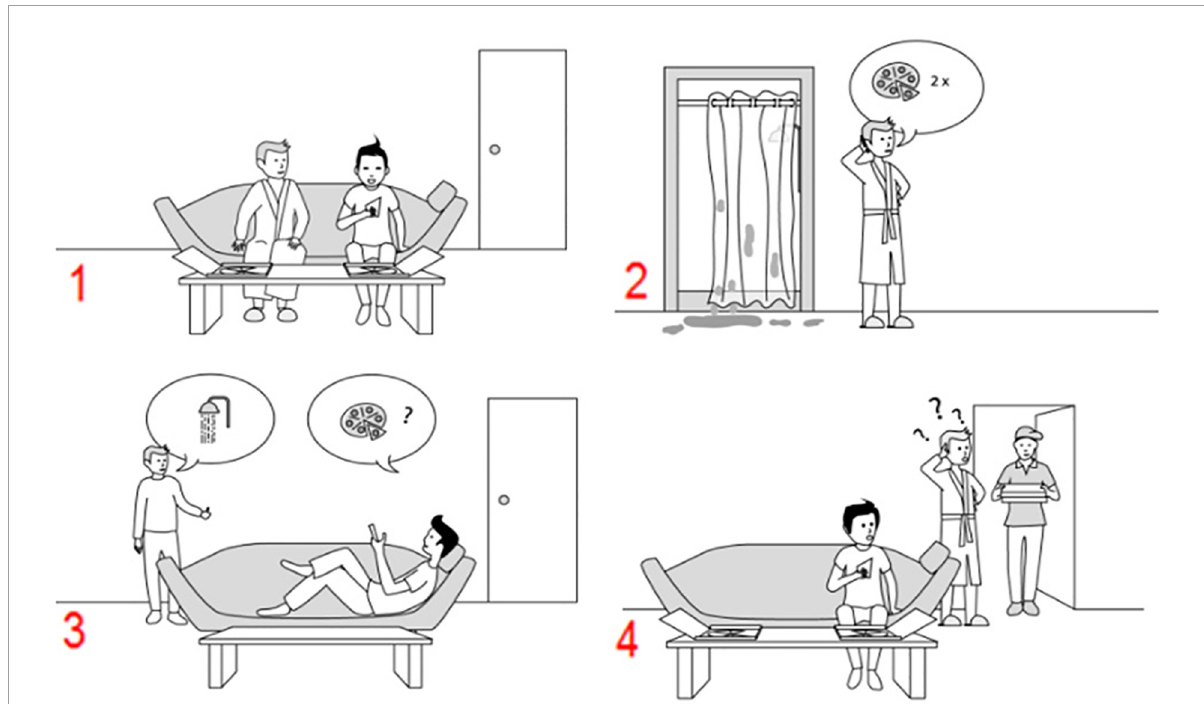
FIGURE2 An example of a false belief sequence in the Pictorial Sequencing Task (the correct order is 3–2–1–4 ). Participants have to select, in the correct order, the first picture on the screen, then the second picture, and so on. Each time, the pictures move in the order indicated by the participant (Heleven et al.,